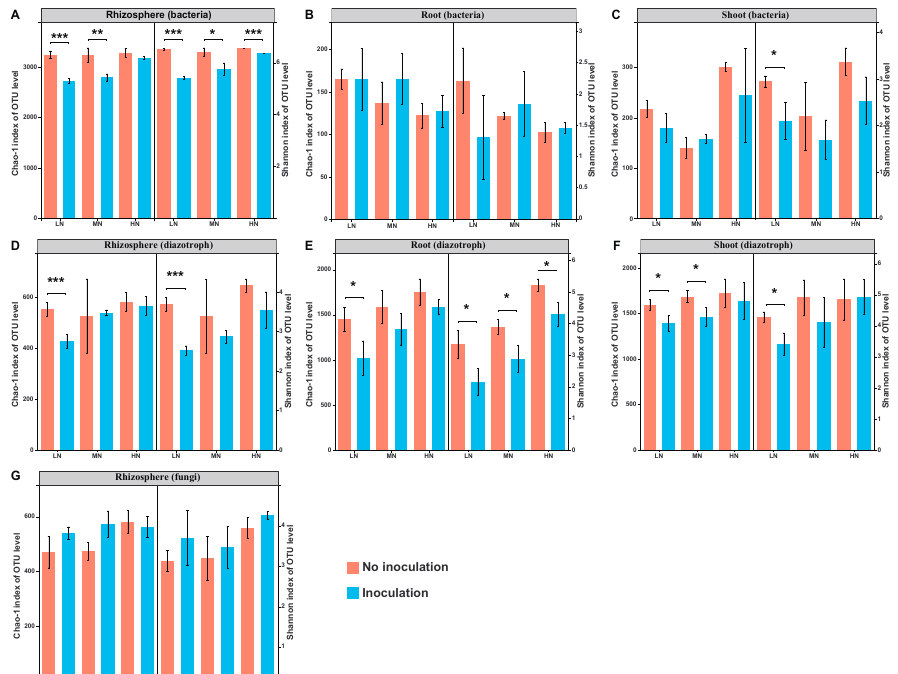
Figure 3. Alpha diversity of the bacterial, diazotrophic and fungal communities in the maize rhizosphere, root and shoot: ( A ) the rhizosphere bacteria; ( B ) the root endophytic bacteria; ( C ) the shoot endophytic bacteria; ( D ) the rhizosphere diazotrophs; ( E ) the root endophytic diazotrophs; ( F ) the shoot endophytic diazotrophs; ( G ) the rhizosphere fungi. The values are given as the means of three independent biological replicates except for shoot endophytic bacteria (two independent biological replicates). The asterisk(s) (* or ** or ***) indicate significant differences between the inoculated and uninoculated groups determined by Student’s t at p < 0.05 or p < 0.01 or p < 0.001. LN: low nitrogen; MN: medium nitrogen; HN: high nitrogen.